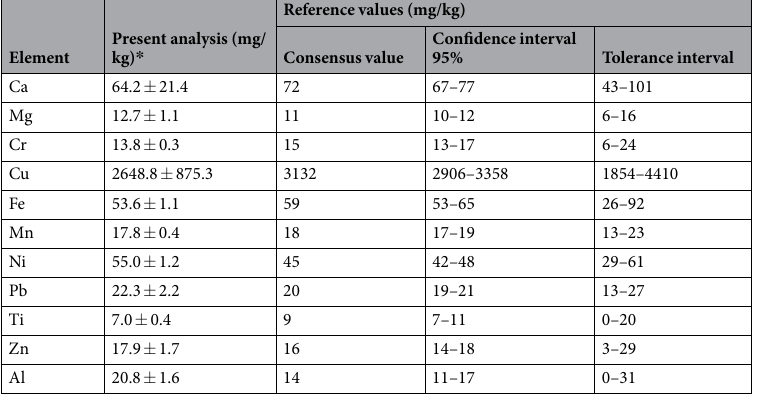
Table 1. Inorganic element concentrations in the certified reference material (EnviroMAT HU-1 Used oil). * Values are means ± SD (four